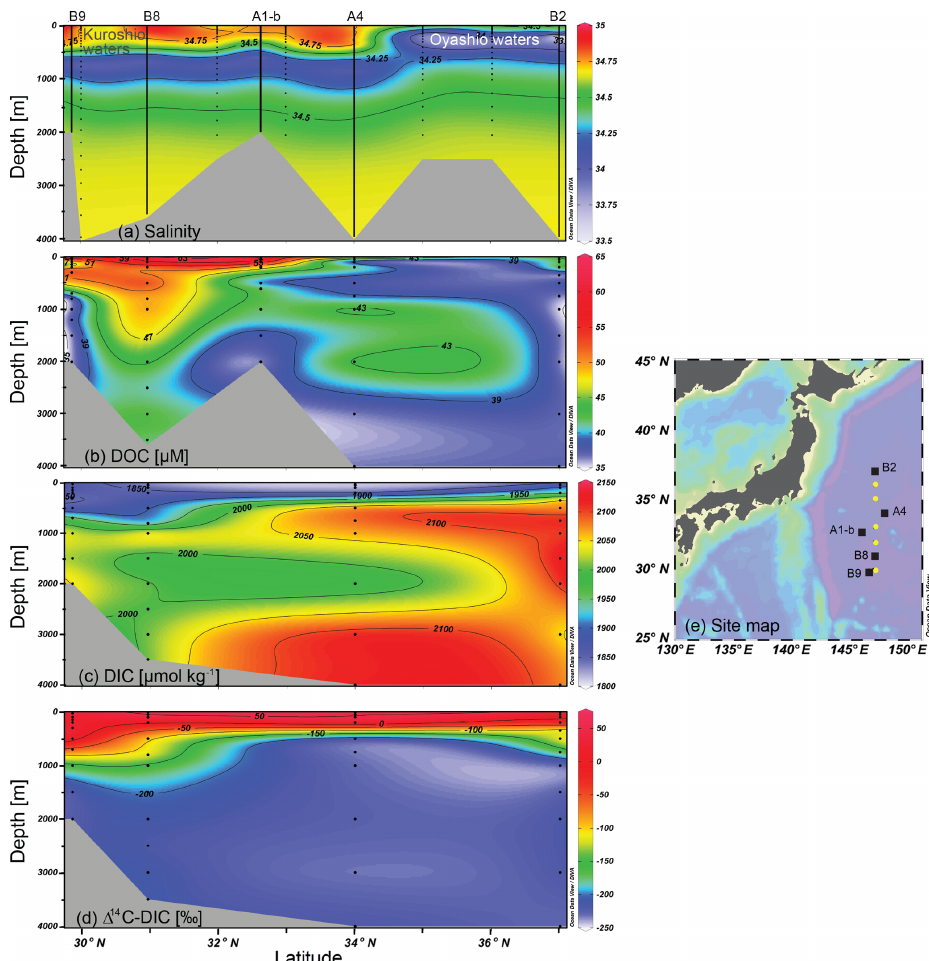
Figure 9. Transectional distributions of (a) salinity, (b) DOC concentrations, (c) DIC concentration and (d) (cid:49) 14 C-DIC values for (e) stations (black squares) sampled across the KE in the northwestern North Pacific. Black dots indicate depths where samples were collected. Note that (a) the salinity of another five stations (yellow circles) along the 147 ◦ E transect is included to support the spreading of the data. The hydrographic data for the five reference stations are taken from the Pacific data source at https://www.nodc.noaa.gov/ocads/ (last access: 24 December 2018). (c–d) DIC concentrations and (cid:49) 14 C-DIC values are given only for four stations due to the lack of data at station A1-b (Ding et al.,